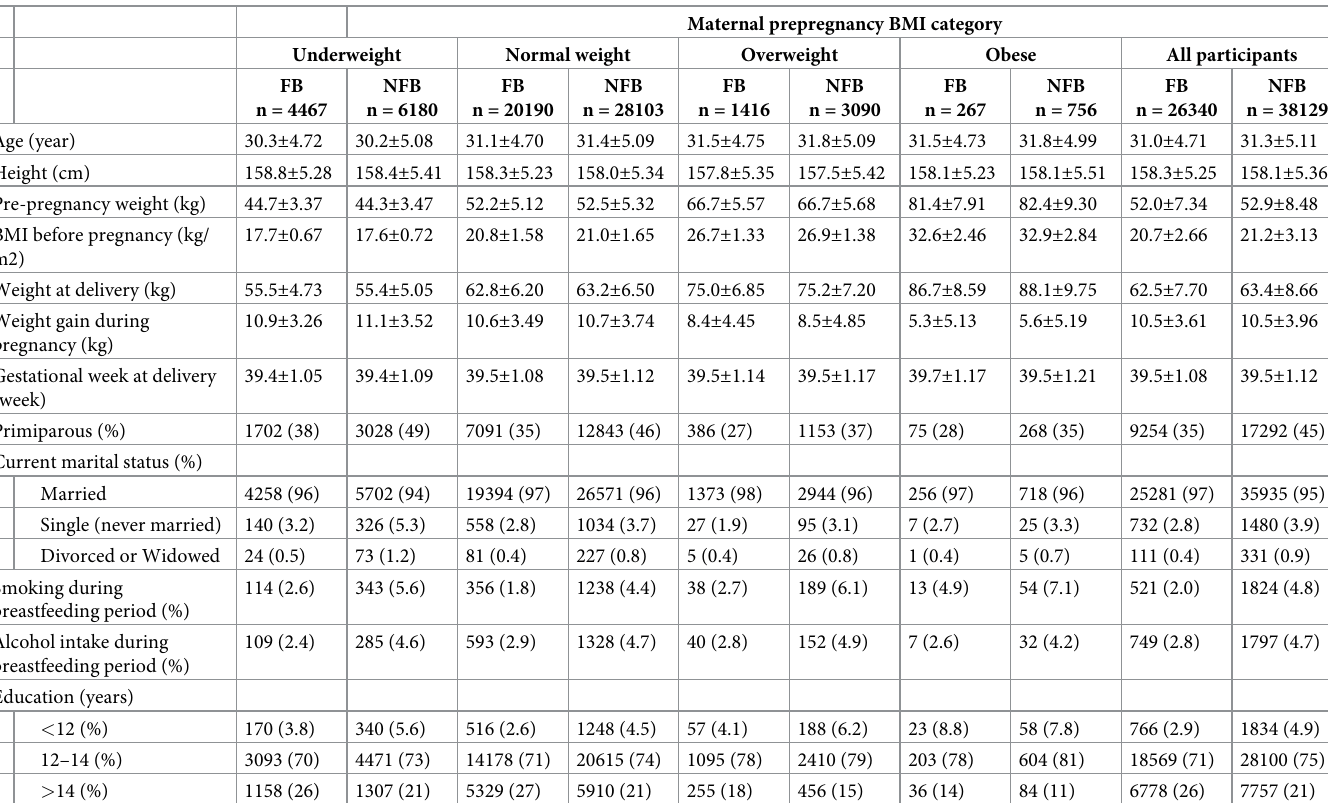
Table 1. Characteristics of participants classified by pre-pregnancy body mass index